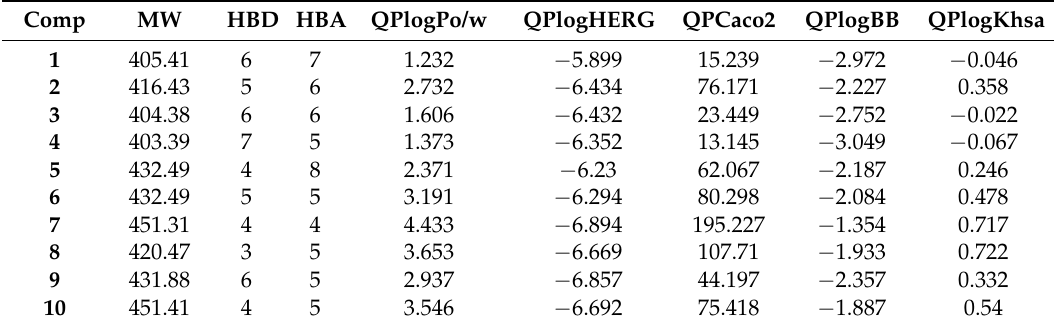
Table 2. Predicted physicochemical/pharmacokinetic properties of the newly designed compounds.